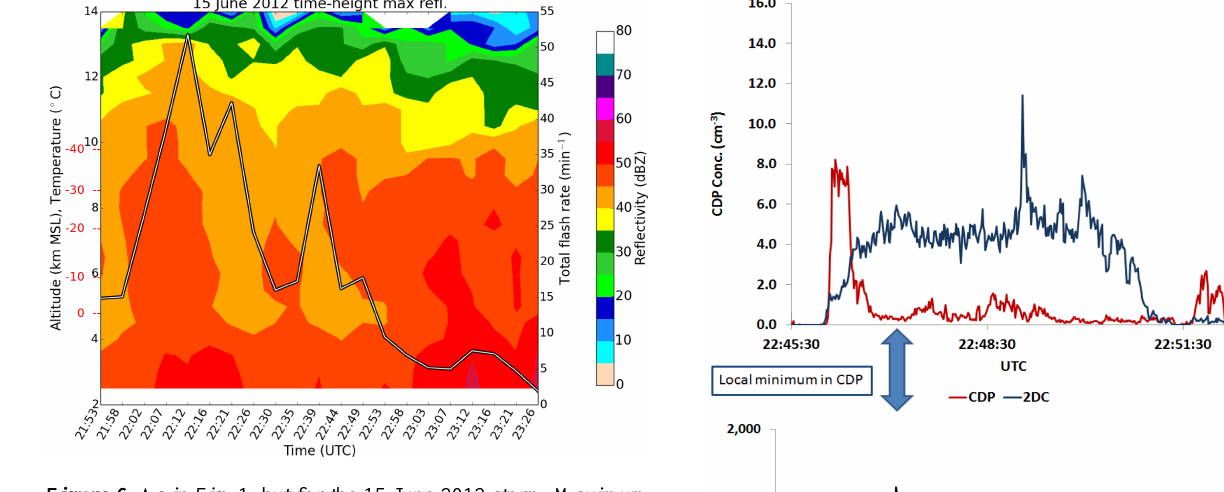
Figure 6. As in Fig. 1, but for the 15 June 2012 storm. Maximum updraft contours are not included because due to this storm’s loca- tion, a dual-Doppler analysis could not be performed.